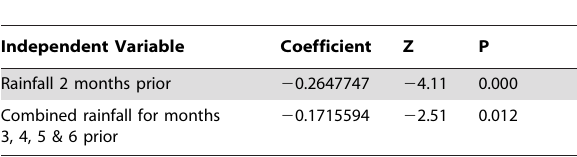
Table 3. Statistical effects of rainfall 2 months prior and rainfall 3, 4, 5 and 6 months prior (combined) on faecal cortisol concentration